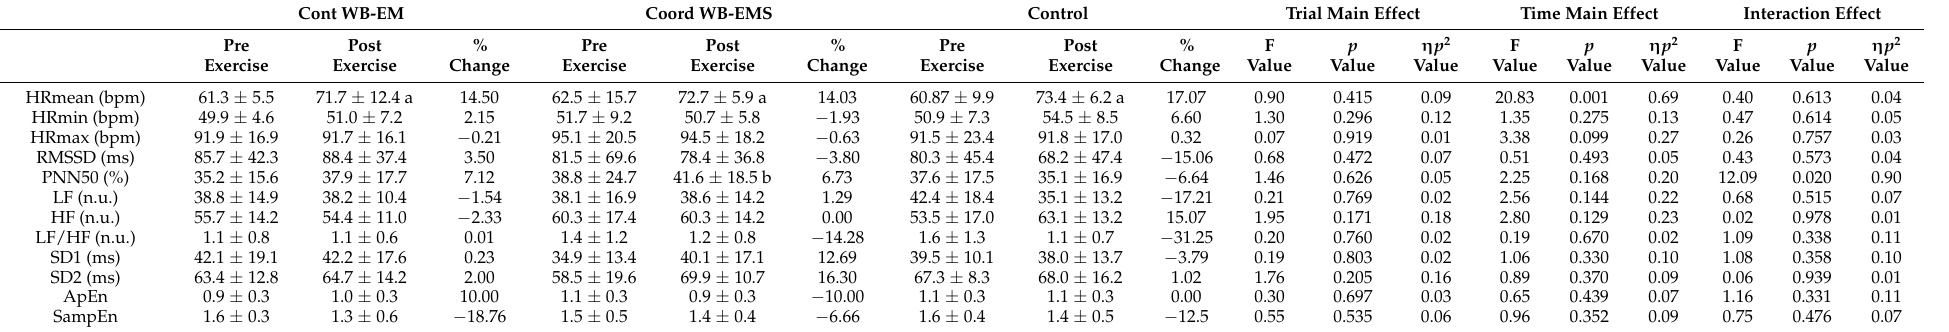
Table 1. Changes (Mean ± SD) in the autonomic stress response after the strength exercise session with the continuous stimulus (Cont WB-EM), coordinated stimulus with concentric and eccentric phases (Coord WB-EMS) and without whole-body electromyostimulation (Control). Cont WB-EM Coord WB-EMS Control Trial Main